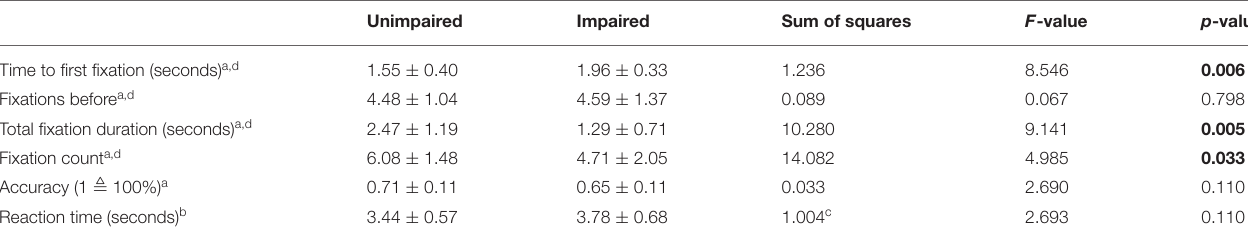
TABLE 3 | Visual search behavior depending on SDMT.